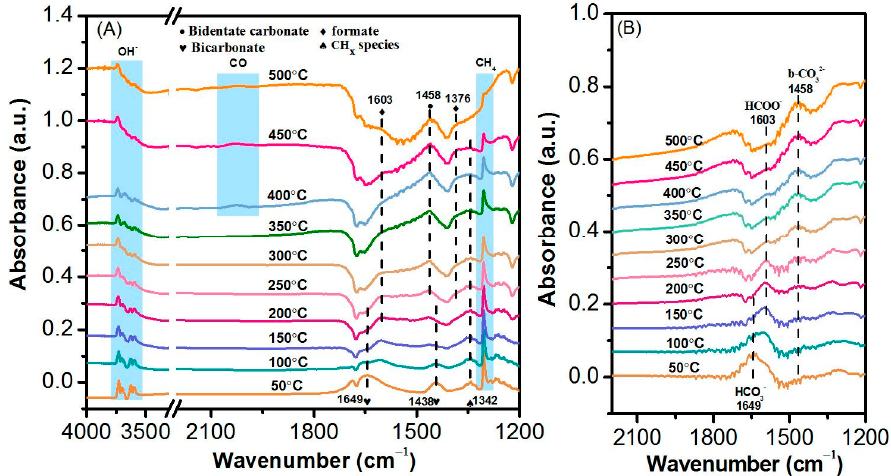
Figure 11. ( A ) In situ DRIFTS spectra of CH 4 + CO 2 reaction on the reduced 5Ni/Ce 0.1 Y 0.9 O x catalyst at different temperatures, ( B ) In situ DRIFTS spectra of CO 2 reaction on the reduced 5Ni/Ce 0.1 Y 0.9 O x catalyst at different temperatures.